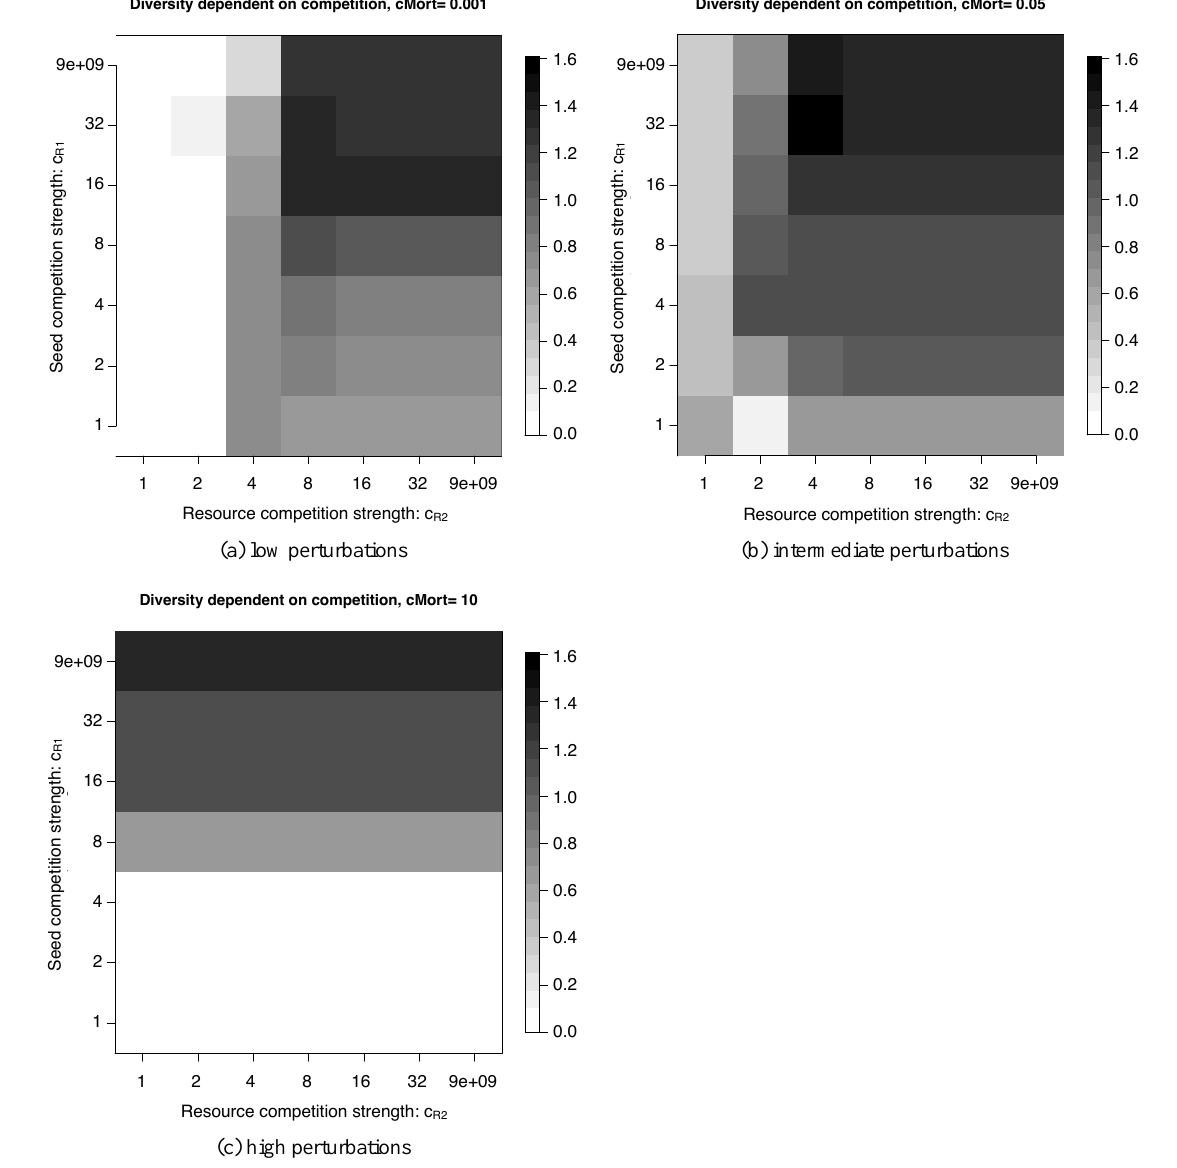
Fig. 8. Each point represents the diversity (Shannon Information Entropy) after 10000 yr of a DIVE simulation dependent on seed (y-axis) and resource competition (x-axis). The values for the strength of seed competition decrease bottom to top and for the strength of resource competition decrease from left to